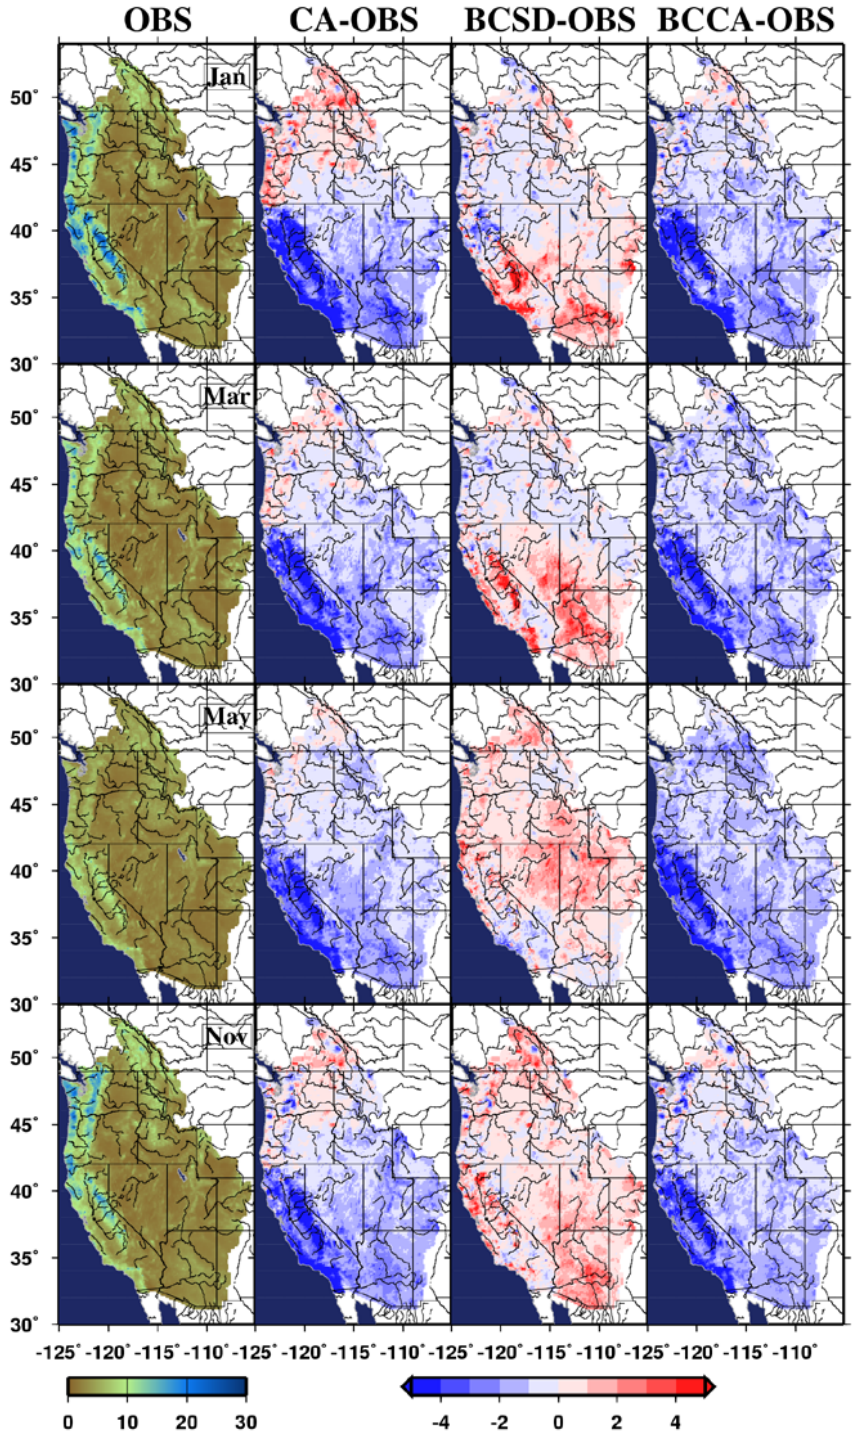
Fig. 2. Precipitation intensity in mm/d for four selected months for gridded observations (OBS, left panels), and the difference between downscaled CA and OBS (second column), between BCSD and OBS (third column), and BCCA and OBS (right panels).